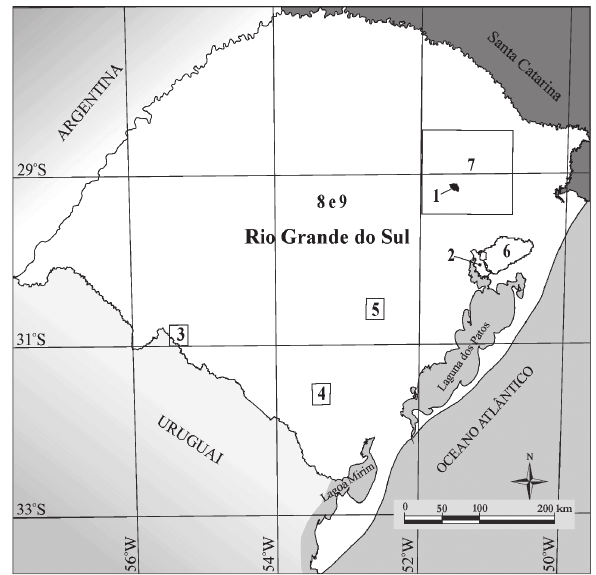
Figura 1. Localização de mapas convencionais de solos do Rio Grande do Sul, elaborados